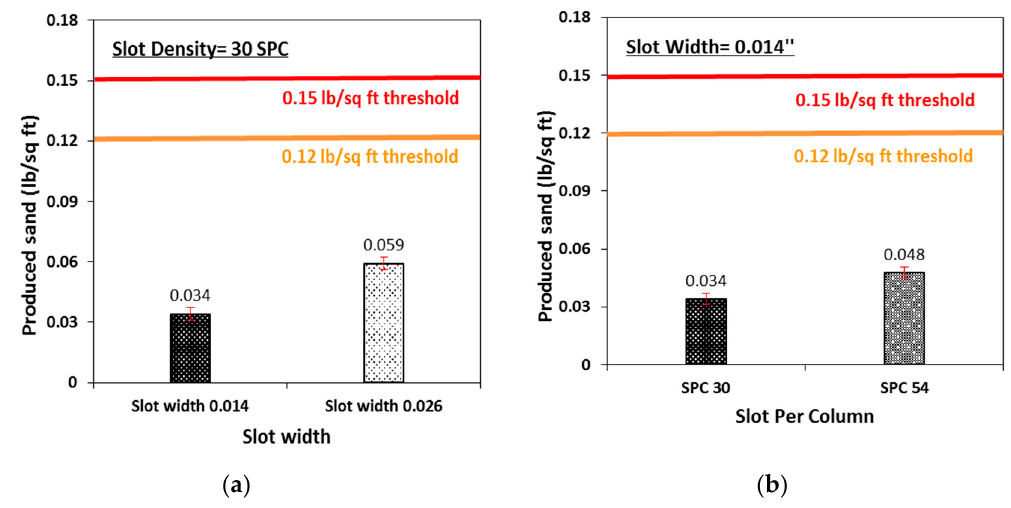
Figure 9. ( a ) Effect of slot width on sand production, ( b ) effect of slot density on sand production at 300